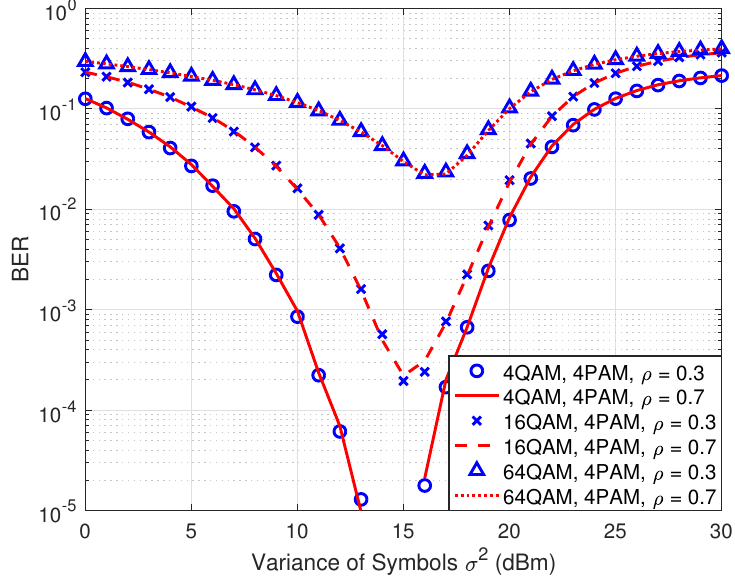
Figure 6. BER performance of the proposed DCHO-OFDM scheme under different variances of